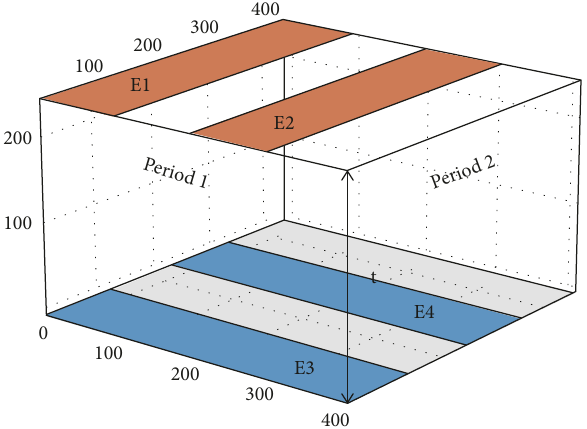
Figure 2: The dimensions of the unit cell FEM model in μ